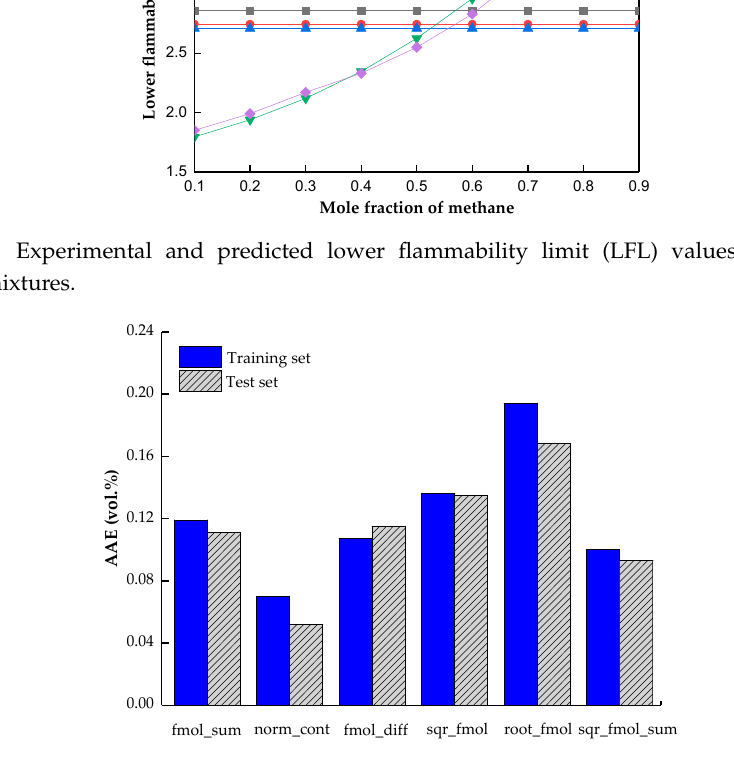
Figure 2. Performance comparisons of the QSPR models for the LFLs of mixtures depending upon the types of mixture descriptors.